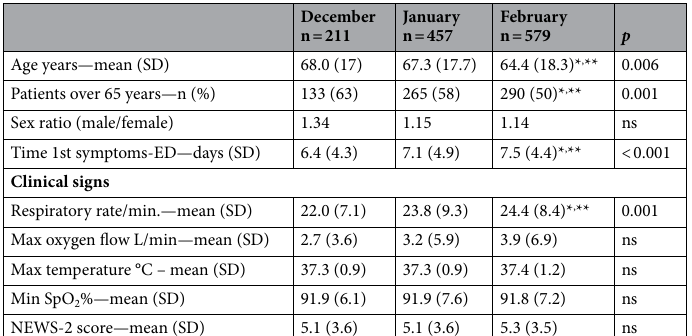
Table 1. Patients and clinical characteristics of Covid-19 patients admitted in the emergency department from December 1st to February 28th. Post hoc analysis (Fischer exact-test or Mann–Whitney U-test, if required): *p < 0.05 versus December **p < 0.05 versus